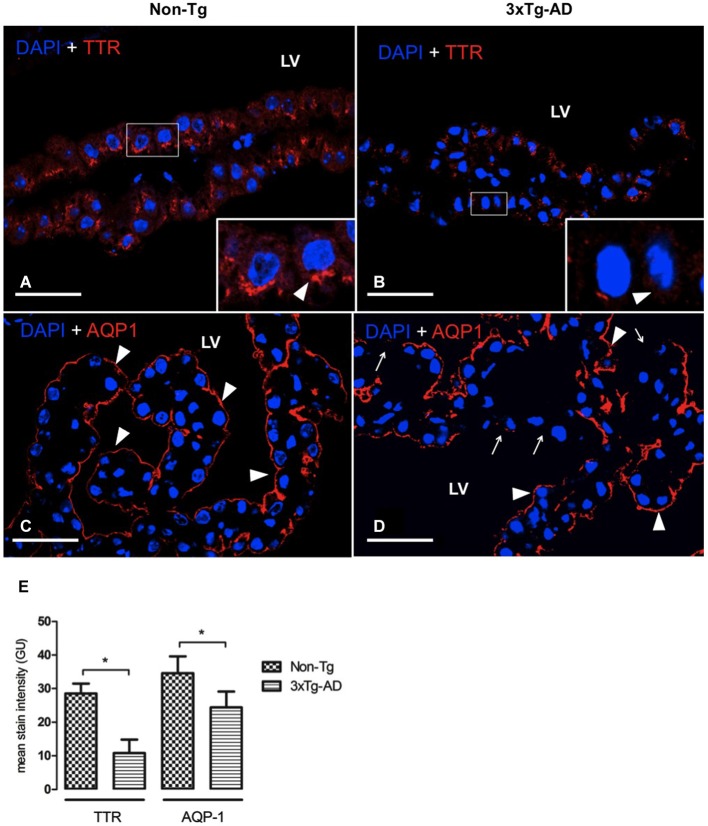
CP confocal images immunolabeled from Non-Tg (A,C) and 3xTg-AD mice (B,D) stained with anti-TTR (A,B) and anti-AQP-1 (C,D). A reduction in cytoplasmic expression of TTR (A,B) as well as in AQP-1 expression in the apical membrane of epithelial cells (C,D) is shown in 3xTg-AD when compared to Non-Tg mice (arrowheads). The arrows in (D) indicate areas where AQP1 was not detected on the apical membrane of CP epithelium. On the left bottom side are represented values of stain intensitites for TTR and AQP-1 (E) as the means ± SEM; LV: lateral ventricle; n = eight animals per group; * p < 0.01 3xTg-AD vs. Non- Tg mice. Scale bars, 30 μm.